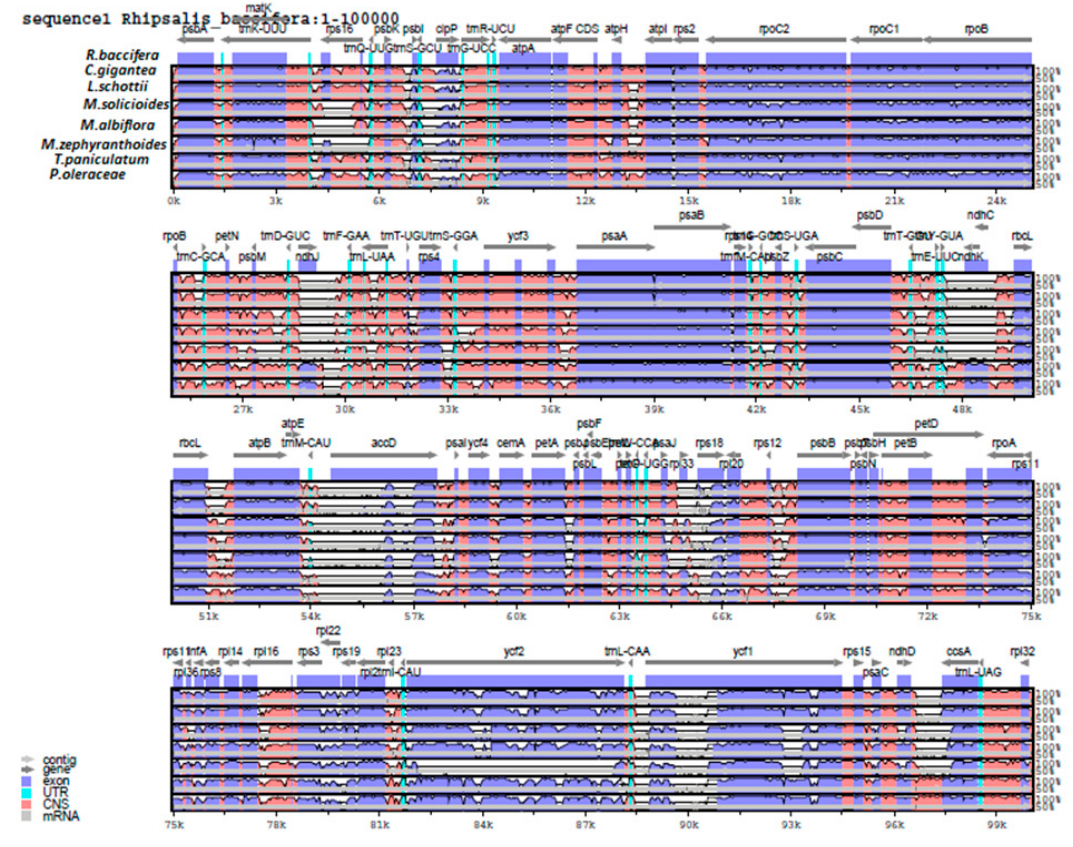
Figure 8. Sequence alignment of eight cp genomes of the suborder Portulacineae using mVISTA program, with the annotation of R. baccifera as a reference. The top line shows genes in order (transcriptional direction indicated with arrow). A cut-off of 70% identity was used for the plots, and the Y-scale represents the percent identity between 50–100%. Genome regions are color coded as exon, intron, and conserved non-coding sequences (CNS).